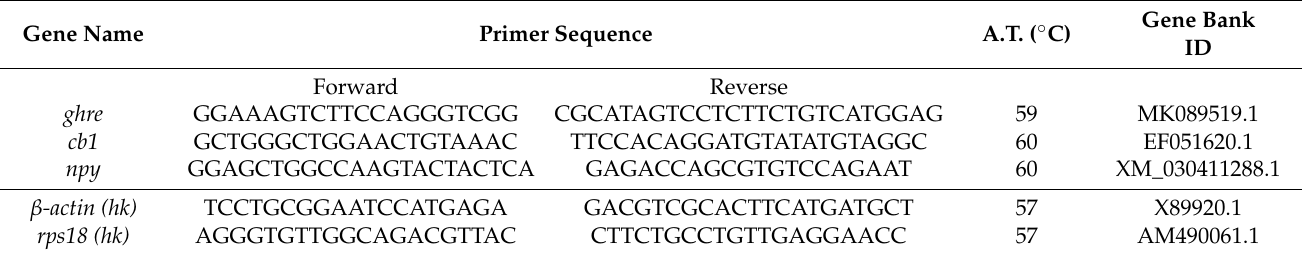
Table 2. Oligonucleotide primers, annealing temperature (A.T.) and location (Gene Bank Accession Number) of each gene investigated in this study. hk : housekeeping